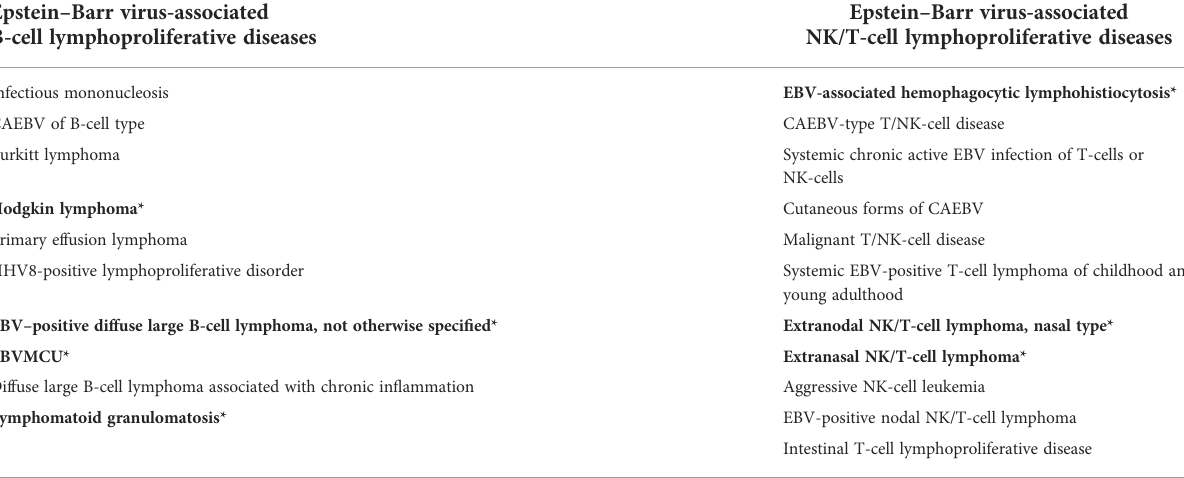
TABLE 2 Epstein – Barr virus-associated B-cell or NK/T-cell lymphoproliferative diseases. Epstein – Barr